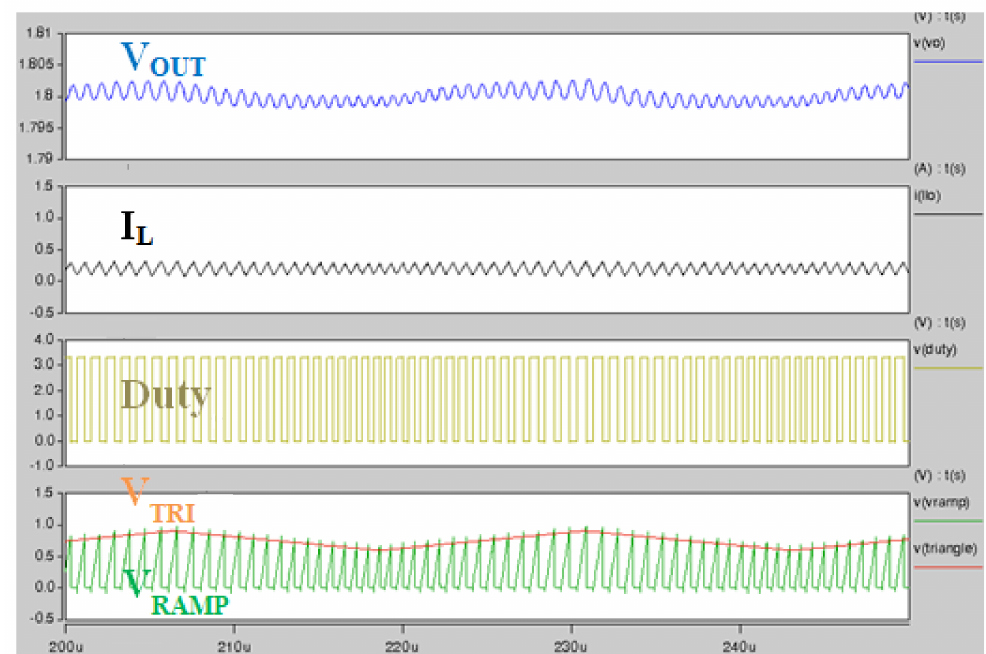
Figure 7. Simulation waveform of the triangular spread-spectrum